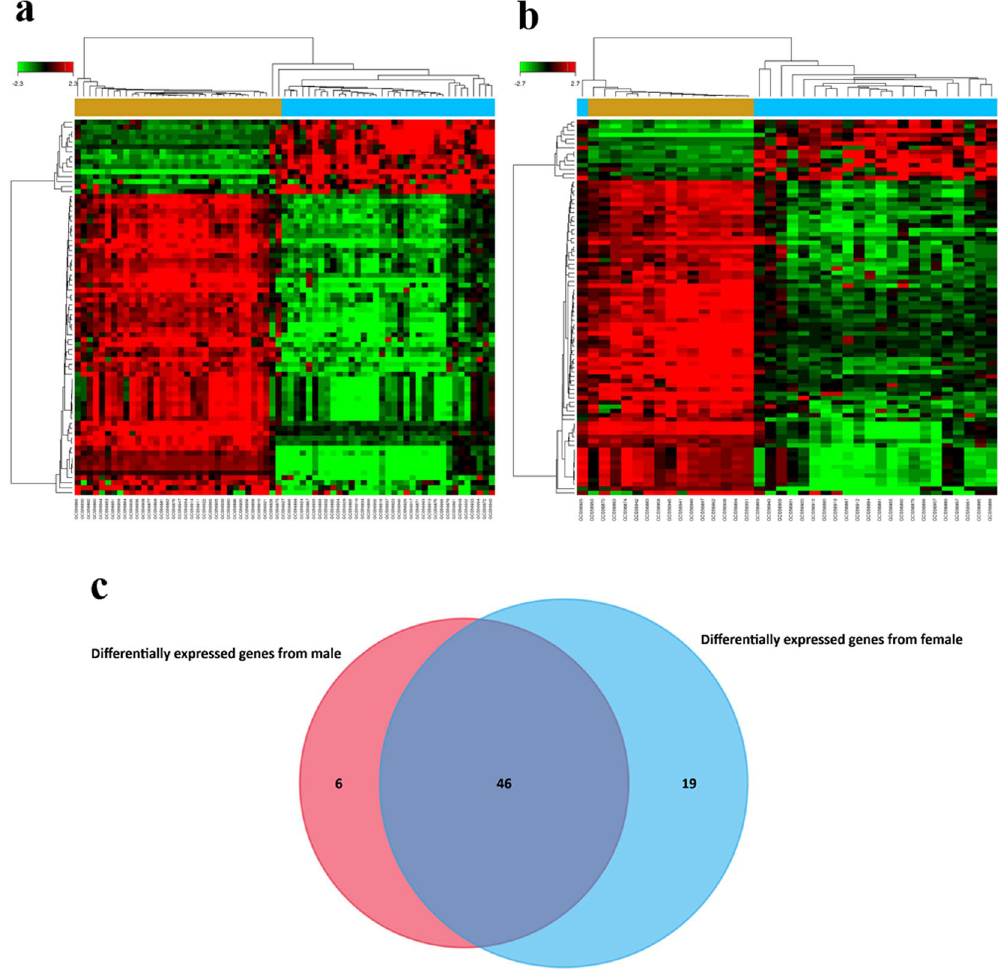
Figure 4. DEGs between lung adenocarcinoma and normal lung tissues for GSE10072. ( a ) Heat map for potential DEGs (n = 76) from males (lung adenocarcinoma n = 35, in blue; normal lung tissues n = 34, in yellow). ( b ) Heat map for potential DEGs (n = 87) from females (lung adenocarcinoma n = 23, in blue; normal lung tissues n = 15, in yellow). ( c ) Duplicate expressions with the same gene symbol and those without a specific gene symbol were removed; the Venn diagram shows DEGs (n = 52) from males, DEGs (n = 65) from females and the co-expressed genes (n = 46) that eliminated gender